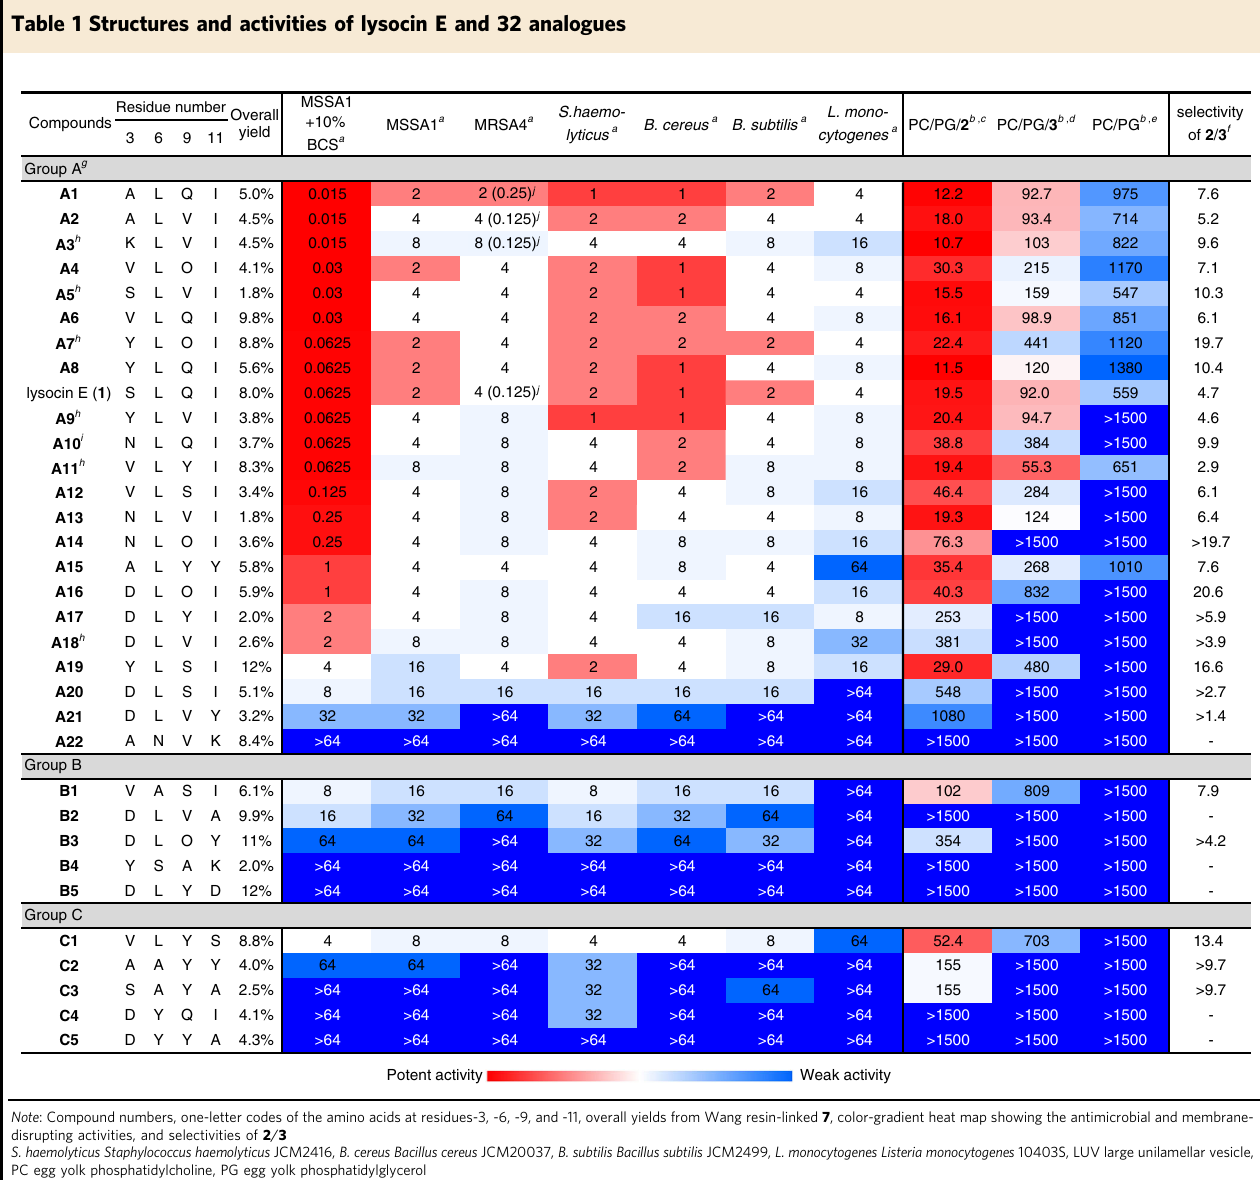
Table 1 Structures and activities of lysocin E and 32